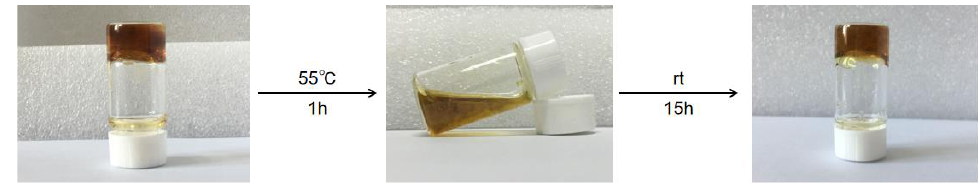
10 of 14 Figure 6. ( a ) Frequency sweep of three hydrogels with H1 (7% terpyridine content), H2 (10% terpyridine content), and H3 (13% terpyridine content); ( b ) strain sweep of H1 , H2 , and H3 . 3.6. Thermo-Responsive Properties